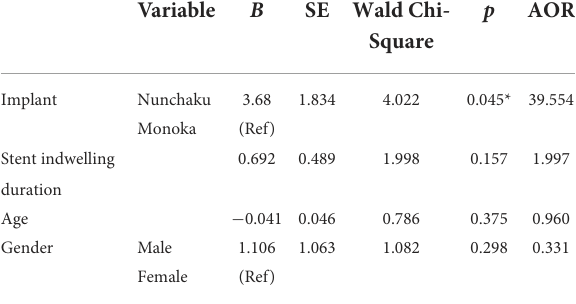
TABLE 3 Binary logistic regression analysis of predictors of surgical success in patients with primary acquired nasolacrimal duct obstruction at 3 months after stent removal.